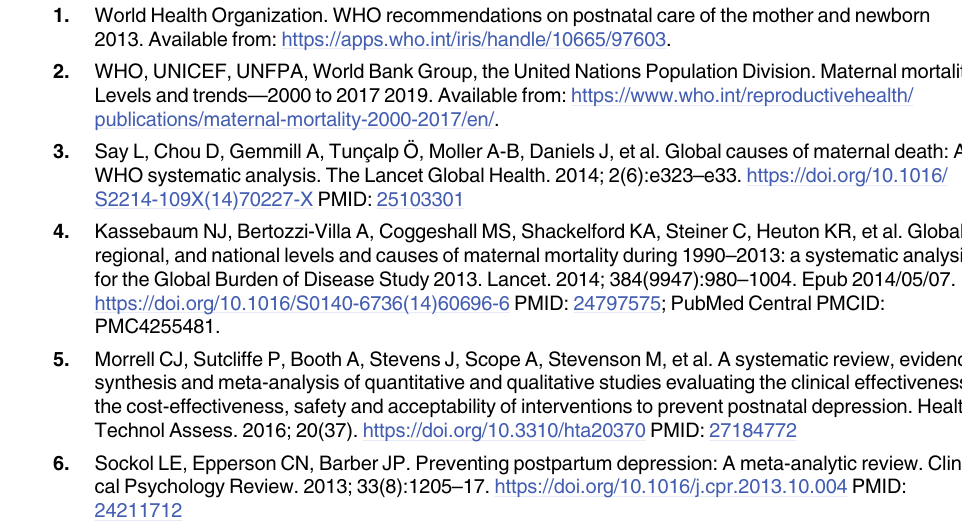
S2 Table. Country distribution of maternal and newborn healthcare providers (n = 424). S3 Table. Analysis disaggregated by type of care provided by respondents (PNC vs no